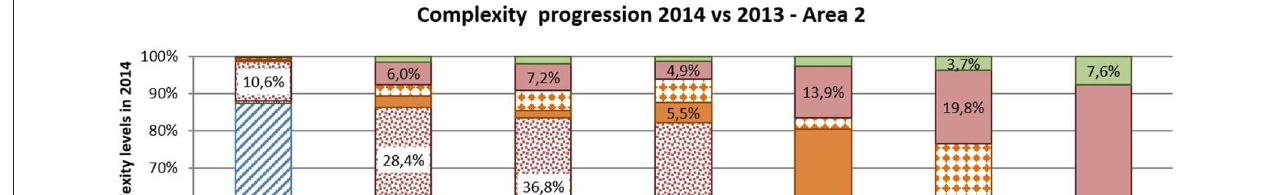
FIGURE 10 | Complexity progression 2014 vs 2013 – Area1.